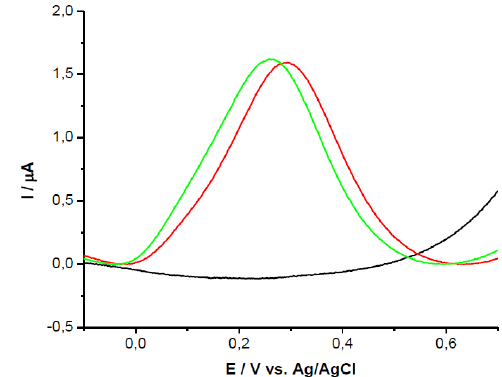
Figure 11. SWVs for: 215.26 µM AA solutions in the absence (red) and in the presence of 215.26 µM propylene glycol (green) compared with the electrolyte (0.1 M PB; pH 7.2) (black).